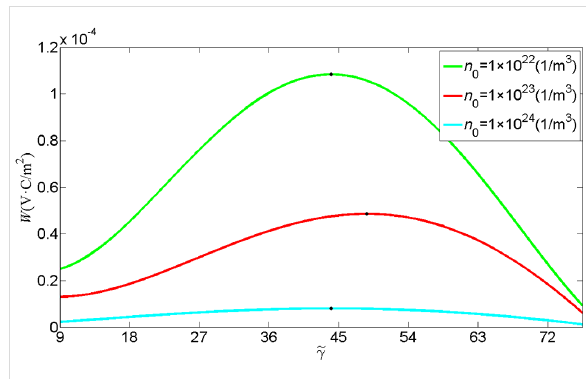
Figure 9: W as a function of the electrode configuration for different initial carrier